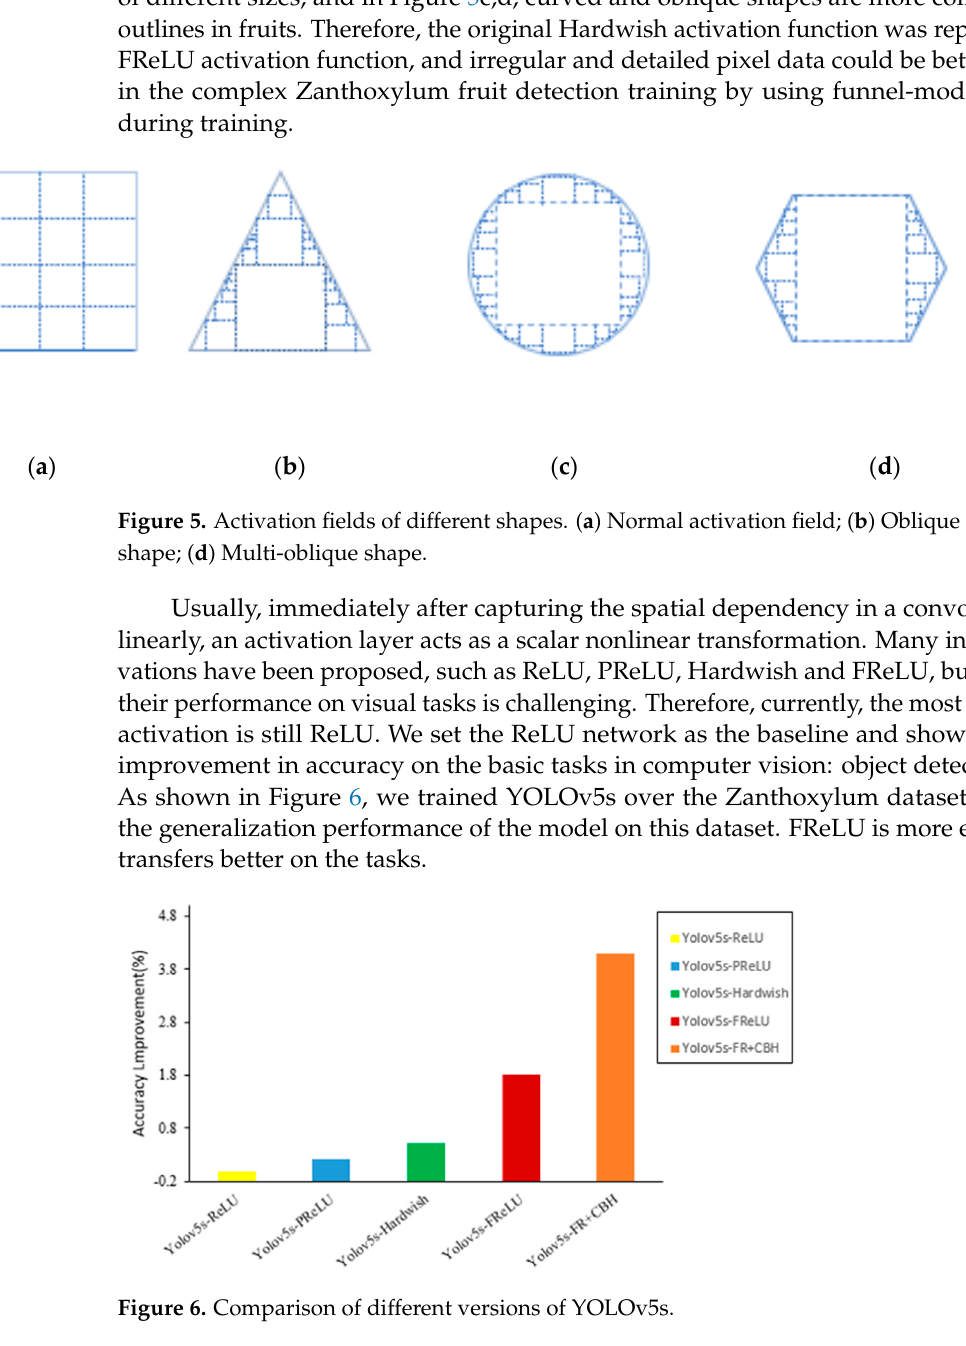
Figure 4. FReLU for visual recognition. ( a ) ReLU: MAX(X,0); ( b ) FReLU: MAX(X,T(X)).